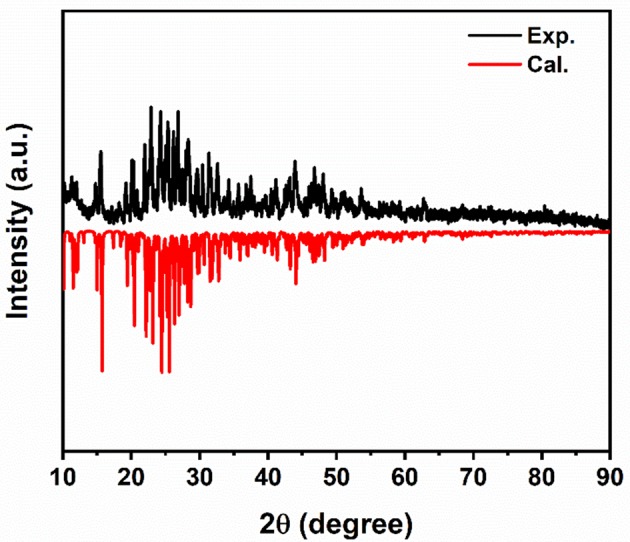
Simulated SCXRD and experimental PXRD patterns of (1-mPQBr)2MnBr4 powders at 300 K.